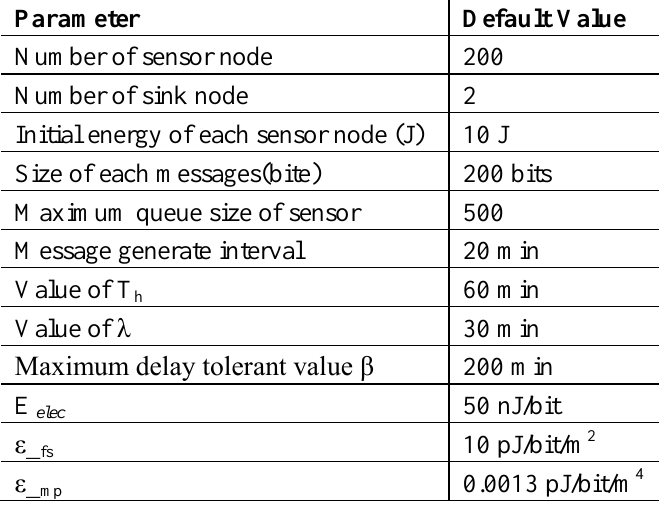
Table 3. Simulation parameters.